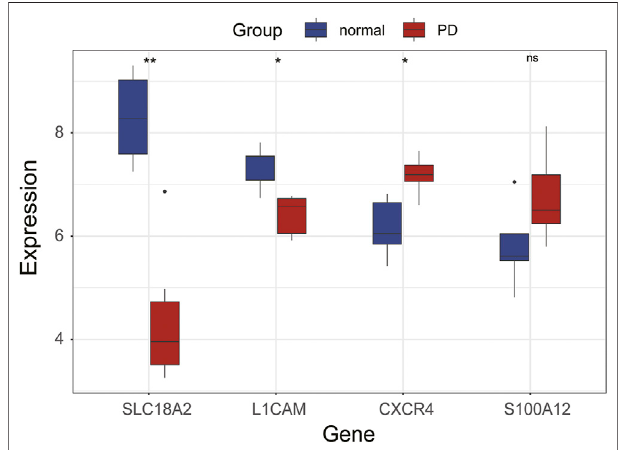
FIGURE 8 | Expression of hub genes in GSE20164. ns, p > 0.05, * p < 0.05, ** p <